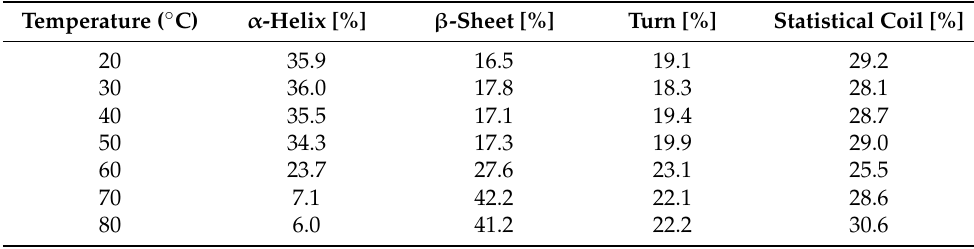
Figure 9. Examination of the thermal stability of the Tt72 pol. ( a ) Tt72 pol’s heat-capacity curves were determined by differential scanning calorimetry (DSC) that was recorded in 20 mM Tris-HCl (pH 8.0) and 50 mM NaCl. The Tt72 pol (black line) and the fit to the two-state model (red line). ( b ) Changes in circular dichroism spectra during thermal denaturation of Tt72 pol. The CD spectra were recorded in 20 mM MES (pH 5.0) and 50 mM NaCl from 200 to 260 nm over a temperature range of 20–80 ◦ C. Representative spectra are shown at specific temperatures during thermal denaturation. Table 1. Predicted changes in the secondary structure of Tt72 pol during thermal denaturation. Changes were calculated by measuring the UV CD spectra from 190 to 260 nM during heating and using the CONTIN/LL [80,81] algorithm provided within the CDPro software package. In CONTIN/LL, the proteins in the reference set are arranged in the order of the increasing RMS distance of the CD spectra from that of the protein analyzed, and the more distant proteins are deleted systematically to construct smaller reference sets. This arrangement results in a set of solutions, one for each LL combination, the number of which is determined by the number of reference proteins and the minimum number of proteins used for a solution. The reference PROTEIN Set Selected was SMP56 (56 Proteins): 43 Soluble + 13 Membrane (with known structures) implemented in the program.